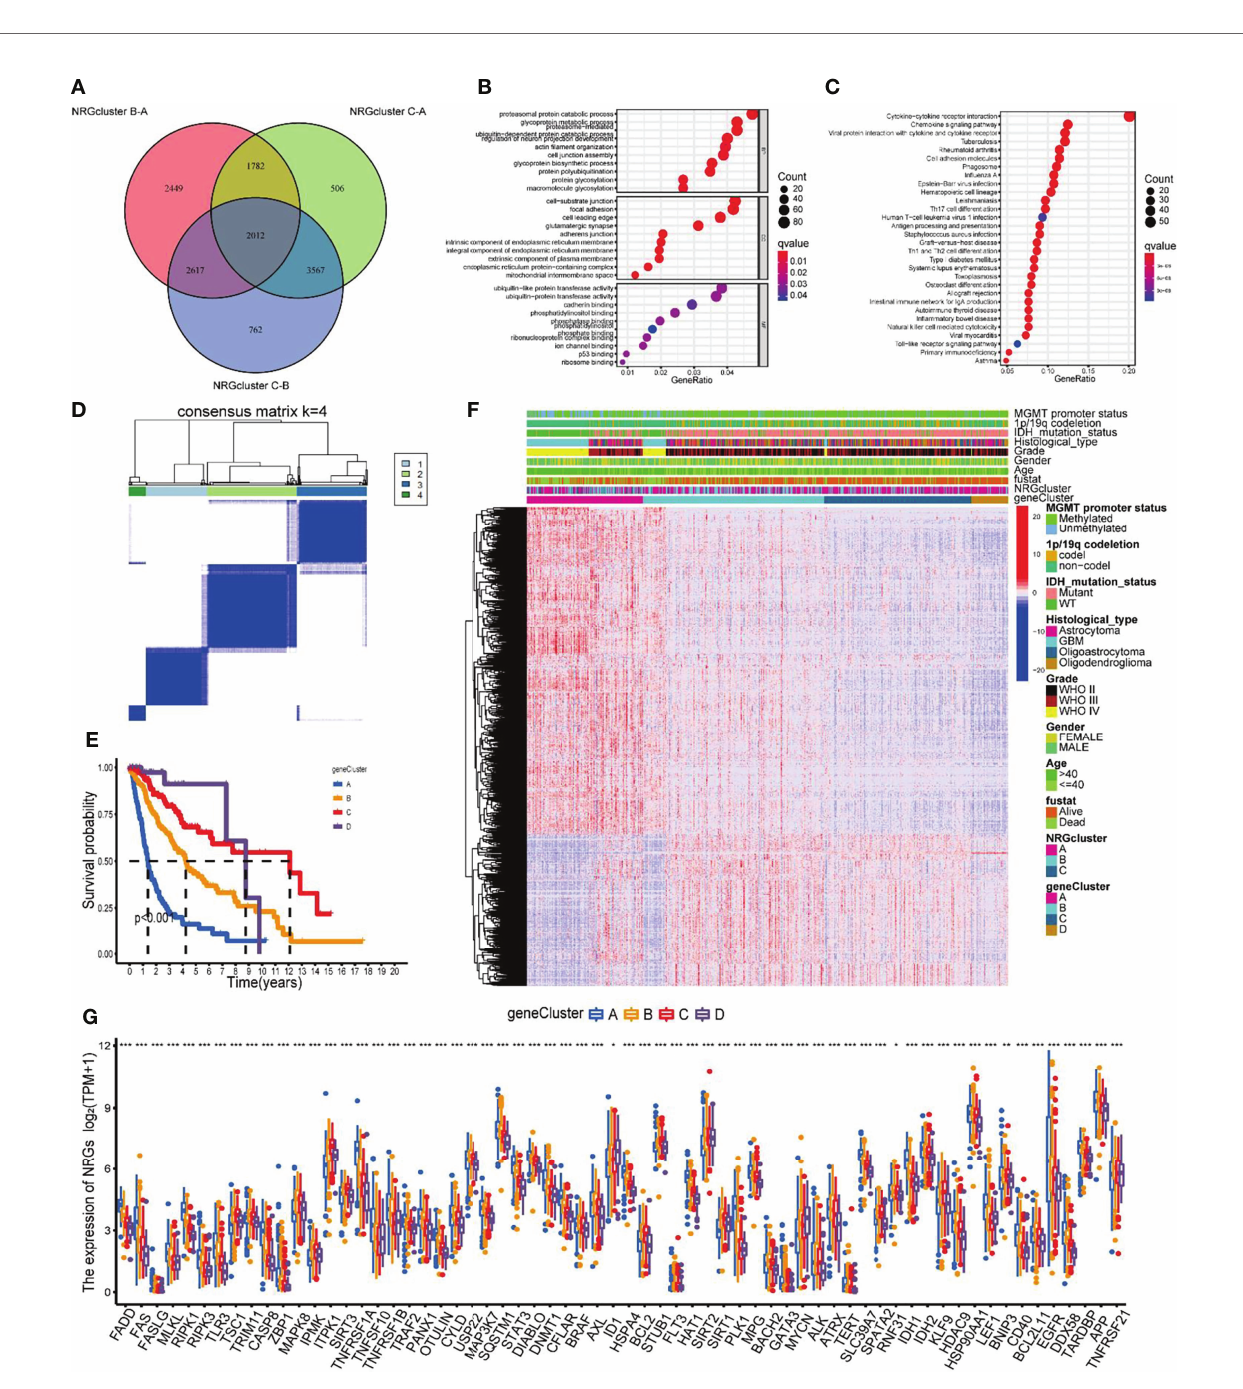
FIGURE 5 | Identi fi cation of gene subtypes based on DEGs. (A) The Venn diagrams for the three NRGclusters. (B, C) Functional enrichment analysis of GO and KEGG for DEGs among three NRGclusters. (D) Heatmap of the consensus clustering matrix (k = 4) dividing glioma patients into four geneClusters. (E) Kaplan-Meier survival analysis of the four geneClusters. (F) The clinicopathologic features of the four geneClusters. (G) The differential expression of 67 NRGs among the geneClusters. DEGs differentially expressed genes; GO, Gene Ontology; KEGG, Kyoto Encyclopedia of Genes and Genomes; NRGs, necroptosis-related genes. ***P<0.001, **P<0.01,